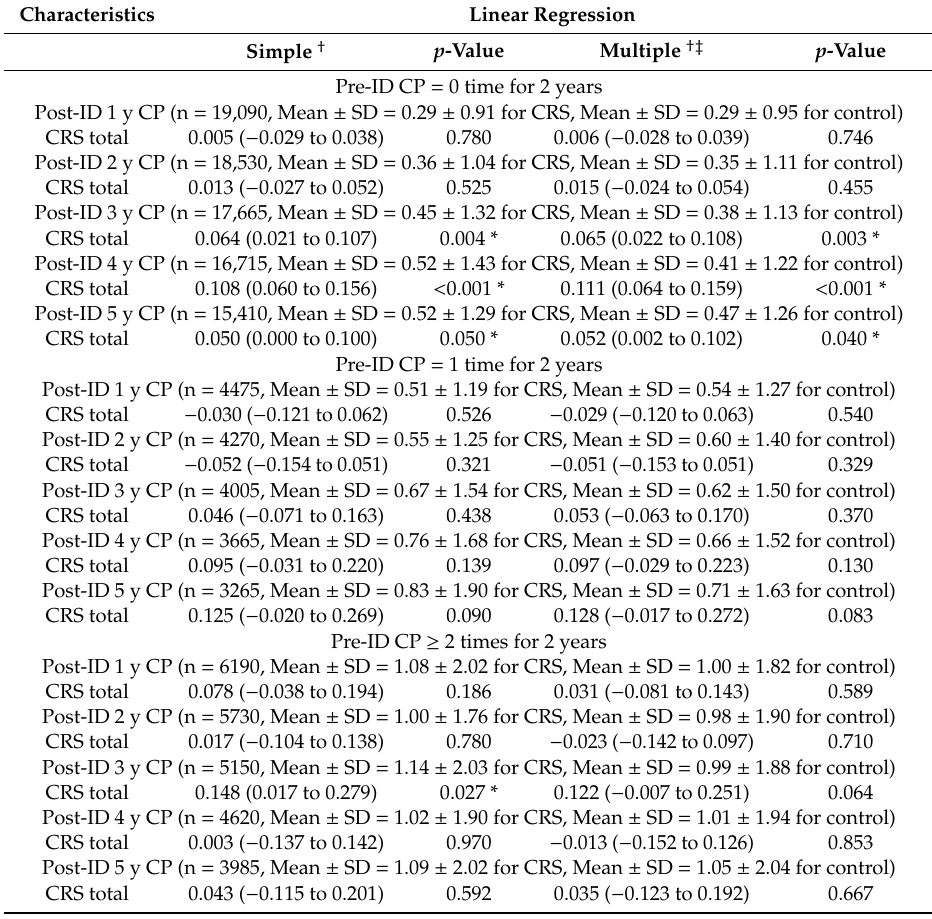
adjusted for obesity, smoking, alcohol consumption, CCI scores, and pre-ID CP for